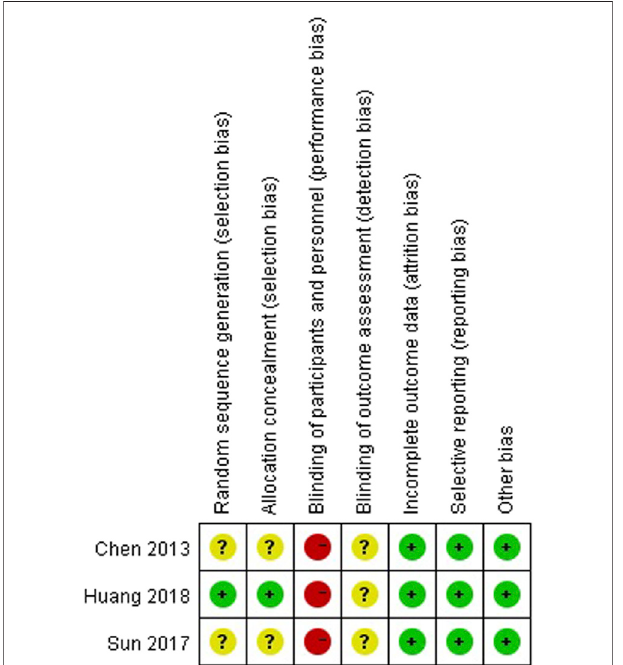
FIGURE 3 | Risk of bias graph depicting each risk of bias item as percentages across prospective studies.